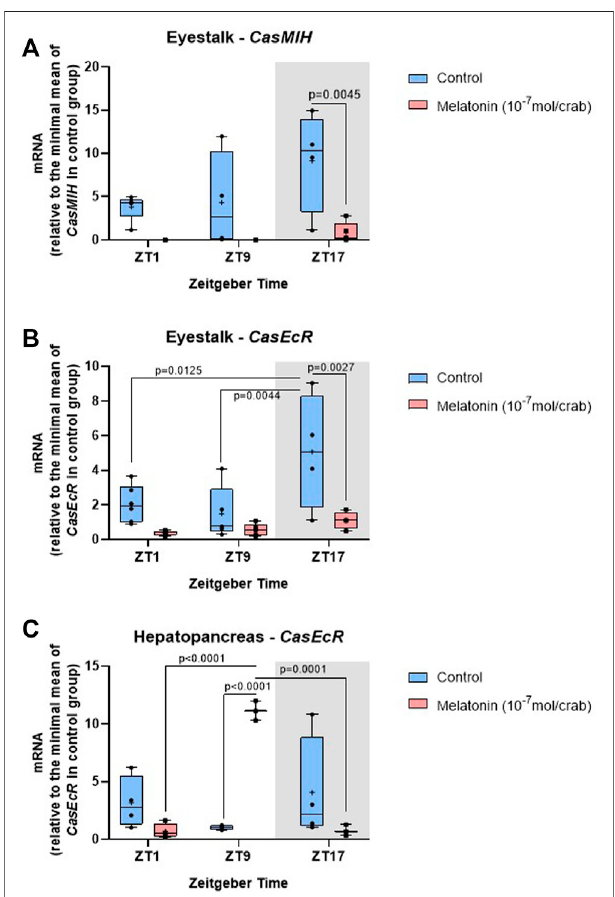
FIGURE 6 | Temporal gene expression in intermolt C. sapidus after daily injections of 10 − 7 mol melatonin/animal for 7 days. (A) CasMIH ( n = 3 – 5) and (B) CasEcR ( n = 4 – 6) in the eyestalks, and (C) CasEcR ( n = 3 – 4) in the hepatopancreas. Total RNA was extracted 1, 9, and 17 h after lights on. Gene expression was normalized by CasRPL12, and the values were expressed relative to the minimal mean of a control in each graph. p values refertothedifferencesbetweenmoltstages,ortemporalpointswithinasingle molt group, as determined by Two-way ANOVA, followed by Bonferroni post-